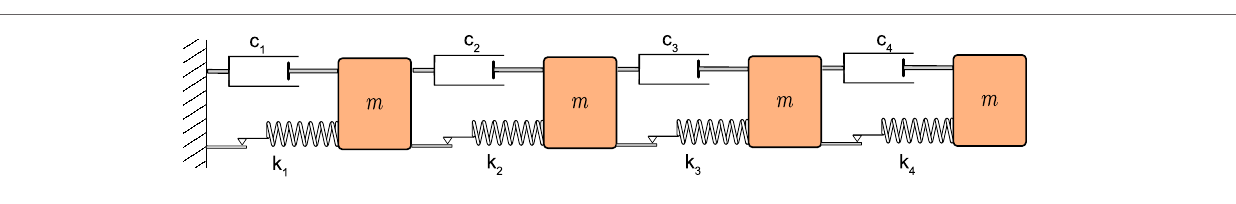
FIGURE 6 | 4 masses system with Bouc–Wen springs and linear